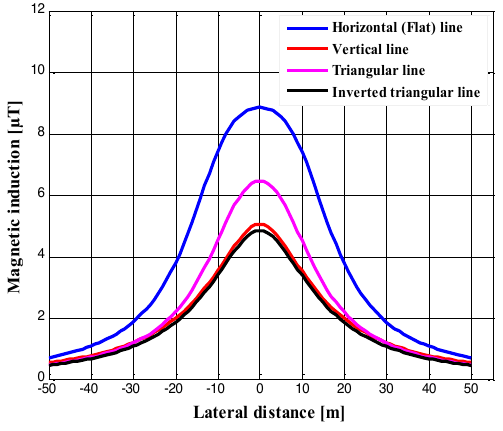
Figure 16: Lateral magnetic induction profile at 1 m above ground for different phase configurations of double-circuit 275 kV power line (500